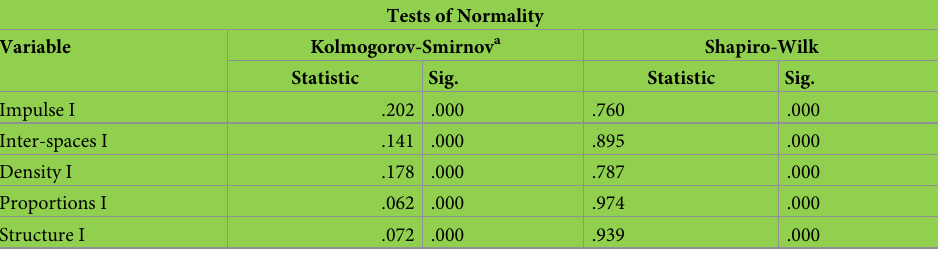
Table 5. Tests of normality for the